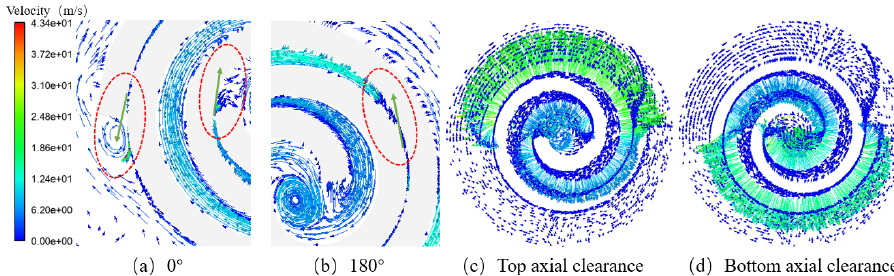
Figure 6. Velocity vector diagram.